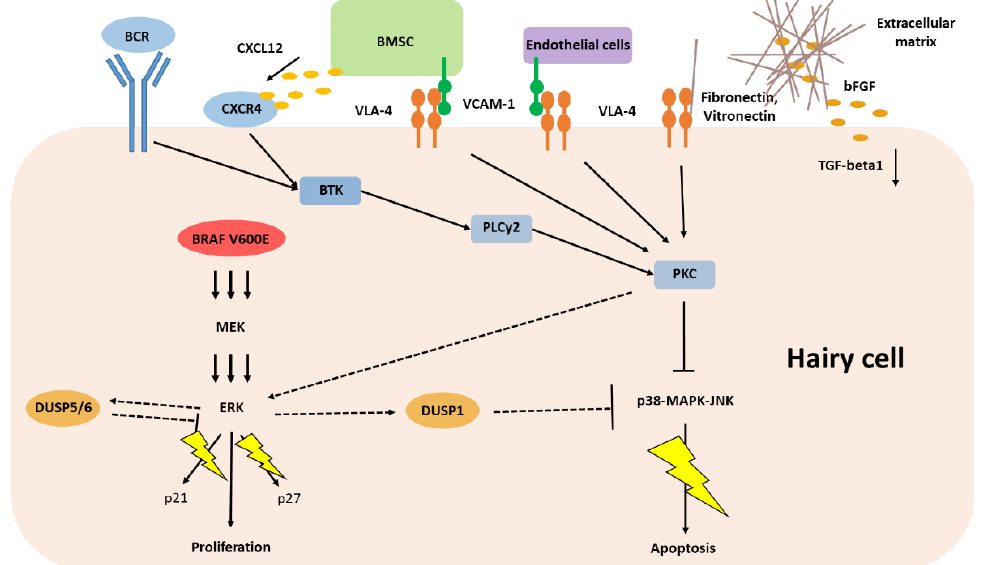
Figure 1. Current understanding of classic hairy cell leukemia biology. Line arrows with thunder illustrate evasion from pro-apoptotic signaling pathways; Dash arrows show proposed signaling outputs of constitutive ERK-signaling derived from preclinical data in BRAF-mutant melanoma cell lines; BRAF V600E, driver mutation in HCL; BCR, B-cell receptor; bFGF, basic fibroblast growth factor; BMSC, mesenchymal bone marrow stromal cells; BTK, Bruton’s tyrosine kinase; CXCL12, C-X-C motif chemokine 12; CXCR4, C-X-C chemokine receptor 4; DUSP, dual specificity phosphatase; ERK, extracellular-signal regulated kinase; JNK, c-Jun N-terminal kinase; MAPK, mitogen-activated protein kinase; MEK, mitogen-activated protein kinase kinase; PKC, protein kinase C; PLCy, phospholipase C gamma; TGF, tumor growth factor; VCAM, vascular cell adhesion molecule; VLA, very late antigen, adhesion molecules.